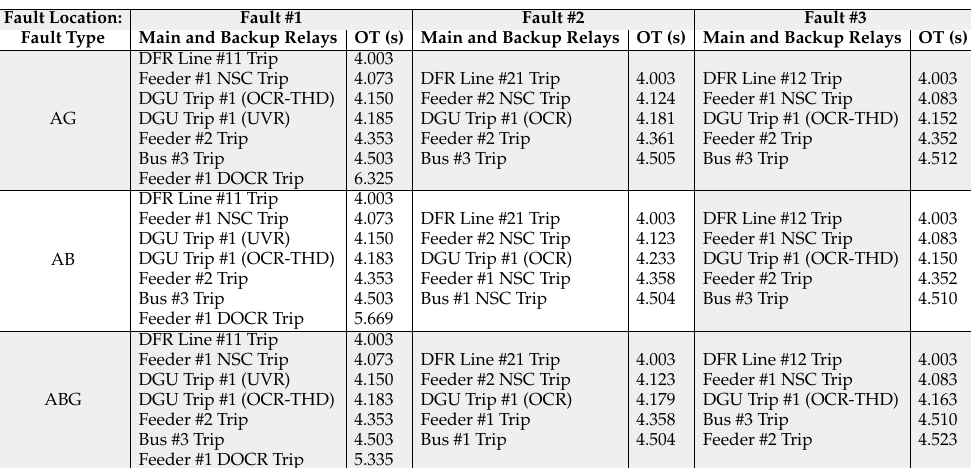
Table 4. Simulation results under different fault conditions in island